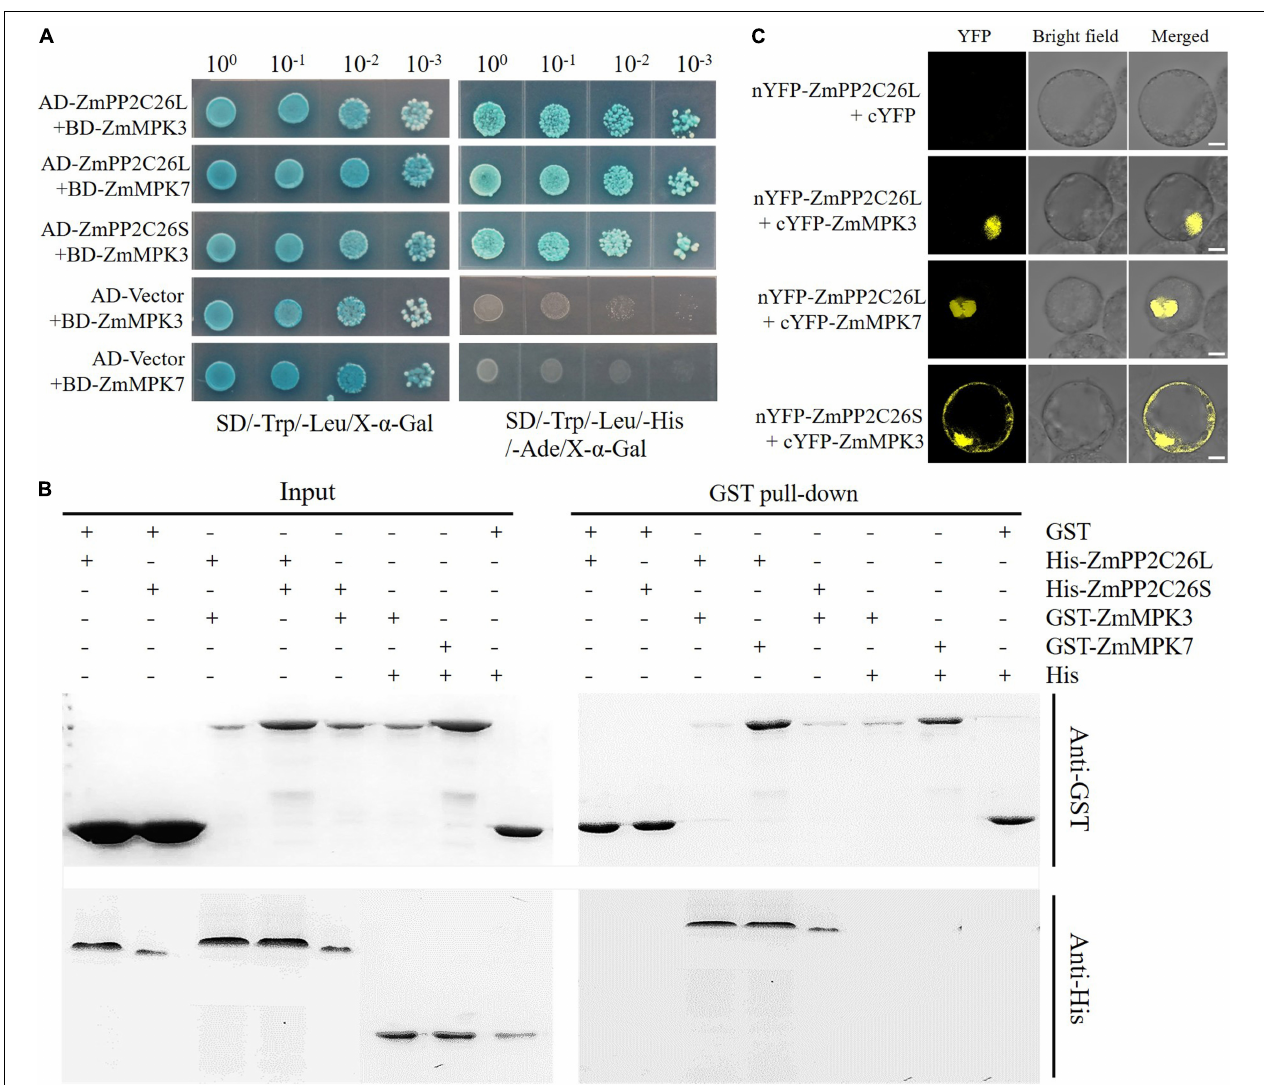
FIGURE 2 | The interaction between ZmPP2C26L/ZmPP2C26S and ZmMAPK3/ZmMAPK7. (A) Y2H assay. (B) GST pull-down assay. (C) BiFC assay. Scale bar = 20 µ m.